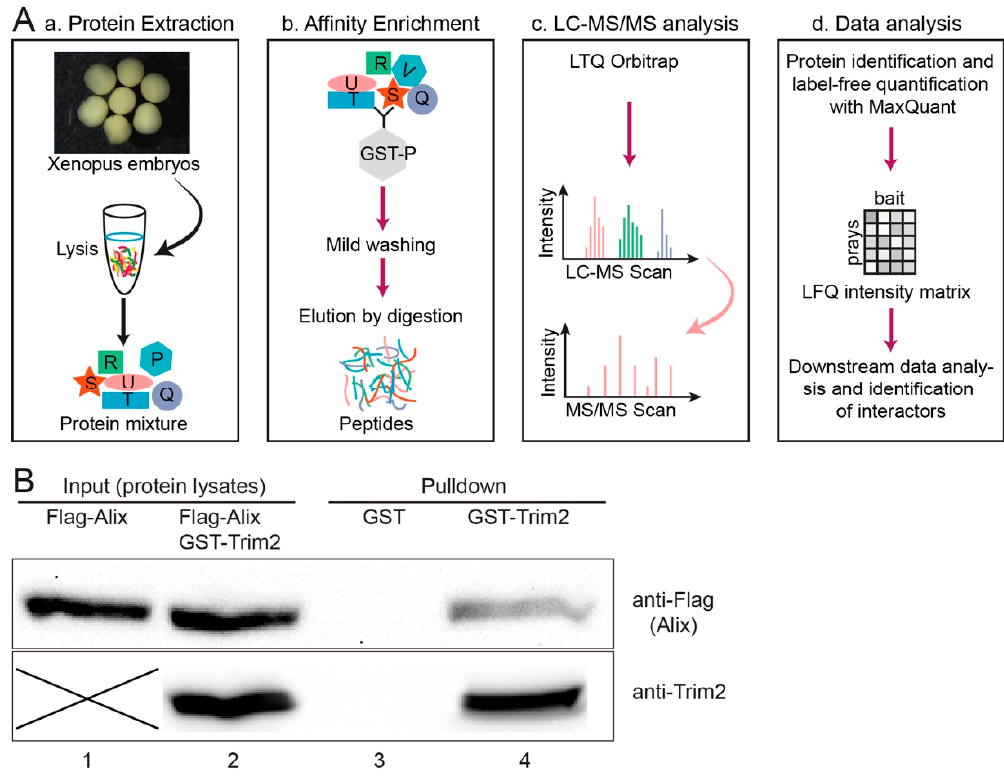
Figure 5. ( A ) Schematic representation of LC-MS/MS analysis for identification of interaction partners, modified after [31]. (a) Protein lysates were extracted from NF stage 30-36 embryos using mild non-denaturing conditions, (b) GST tagged bait protein and protein interactors from the embryo lysates were enriched by GSH-Sepharose. Subsequently, bound proteins were digested into peptides. (c) The peptide mixture was analyzed by single-shot liquid chromatography tandem mass spectrometry (LC-MS/MS) on an Orbitrap instrument (see acknowledgement). (d) Raw data were processed with MaxQuant to identify and quantify proteins and to identify interacting proteins. ( B ) Interaction of Trim2 and Alix was verified by GST pulldown assay using GST-Trim2 as bait and lysates of HEK293T cells transfected with Flag-Alix by Western blot. Cell lysates with input proteins (Lanes 1 and 2). GST alone serves as a control (Lane 3). Eluted flag-tagged Alix after binding GST-Trim2 (Lane 4, upper blot). Note: images of the blots are cropped accordingly to the area of exposed protein bands. Uncropped blots in Figure S4. Two different gels/bolts were used to show the eluted flag-tagged Alix and precipitated GST-Trim2 of the same sample.